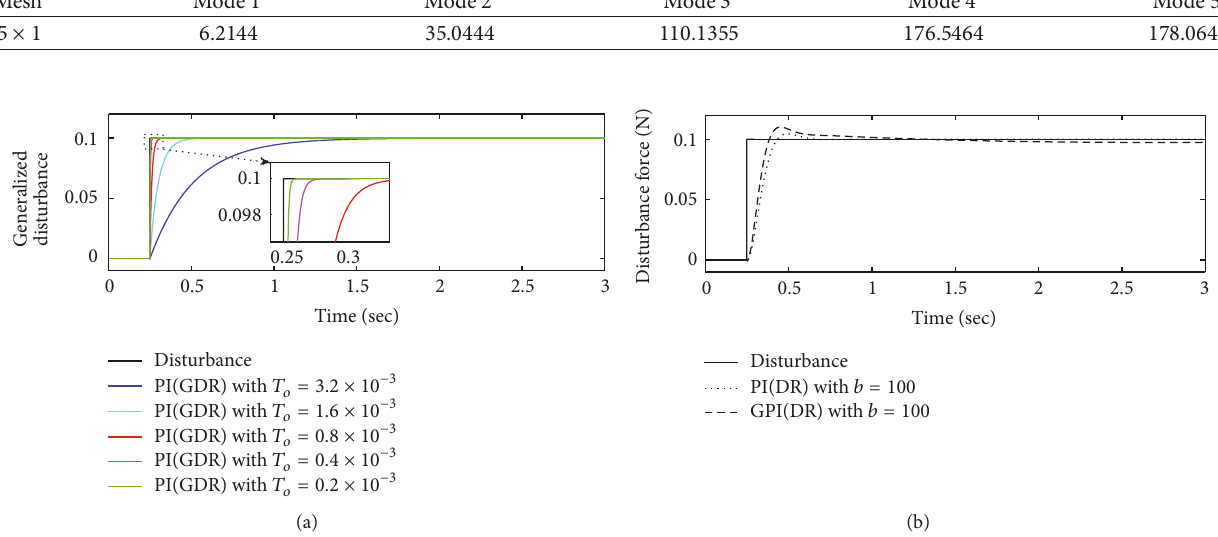
Figure 2: Estimated step disturbances by PI (DR), GPI (DR), and PI (GDR) observers with different gain parameters.